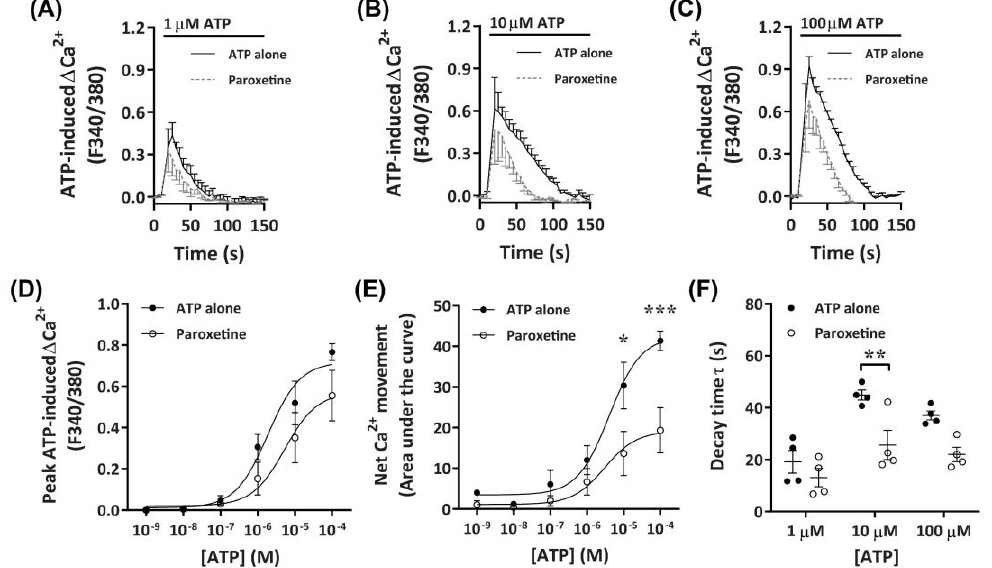
Figure 4. ATP-induced Ca 2+ responses in DH82 cells in the absence or presence of paroxetine. ( A – F ) DH82 cells in ECS were loaded with Fura-2 and preincubated in the absence (ATP alone) or presence of 100 µM paroxetine (both 0.3% dimethyl sulfoxide; DMSO) for 5 min. Cells were then exposed to increasing concentrations of ATP and Fura-2 fluorescence was recorded. ( A – C ) ATP-induced Ca 2+ traces (F340/380) were plotted and the ( D ) peak Ca 2+ response and ( E ) net Ca 2+ movement were fit to the Hill